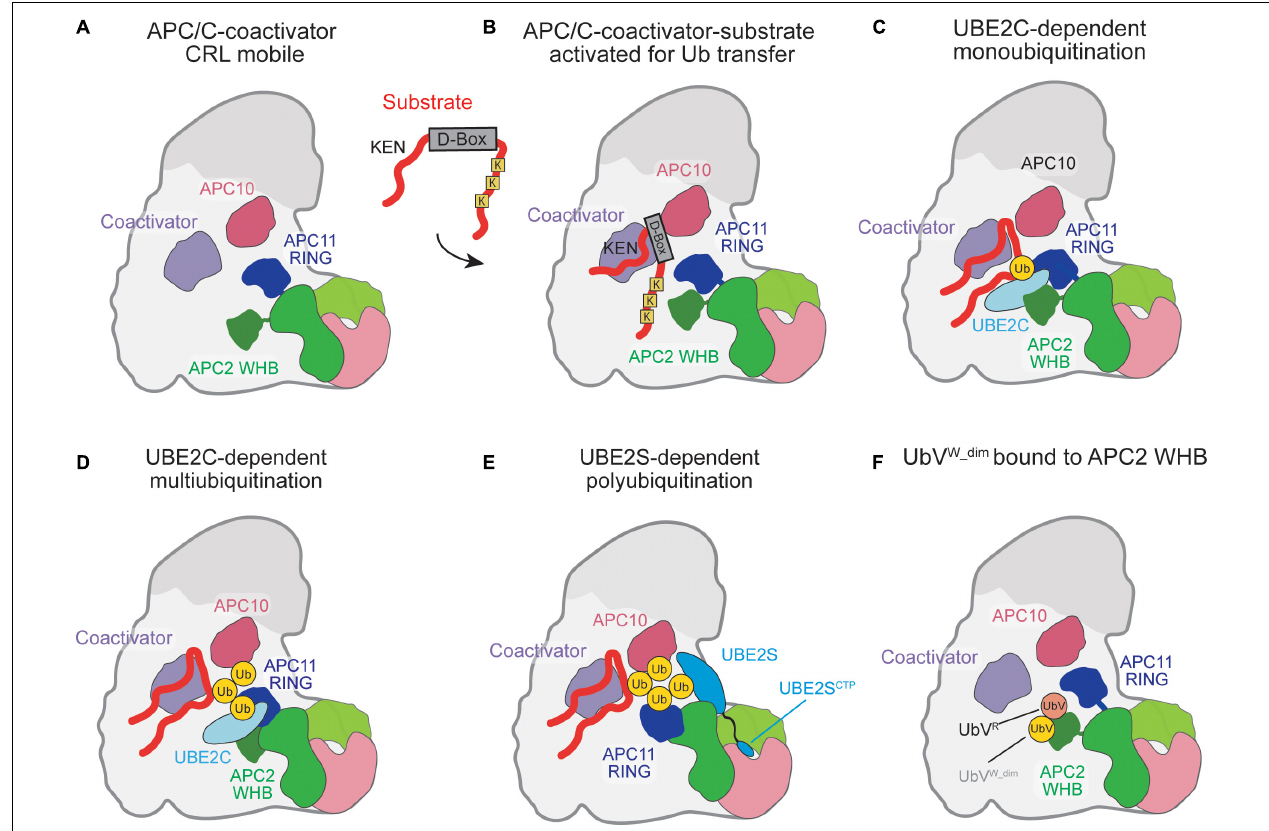
FIGURE 2 | Schematic of ubiquitination reaction mechanisms catalyzed by the APC/C. (A) Coactivator-bound APC/C with the raised CRL being activated for Ub transfer as the APC2 WHB and APC11 RING domains are highly mobile. (B) Substrate recognition is mediated by the coactivator and APC10 which recognize the D-box on substrates. Substrate lysines are positioned near the E2 binding sites for Ub transfer by the RING. (C) UBE2C is clamped in place by the APC2 WHB and APC11 RING and positioned for catalysis of Ub transfer by the APC11-RING. (D) Multiple rounds of UBE2C ∼ Ub binding result in multiubiquitination. (E) UBE2S catalytic domain binds to APC2. The UBE2S CTP assists in UBE2S recruitment and activation of the APC/C catalytic domains by docking to the APC2/4 groove. (F) A cryptic Ub-binding site on the APC2 WHB amplifies recruitment of Ub to the APC/C, with a preference for K48-linked chains.